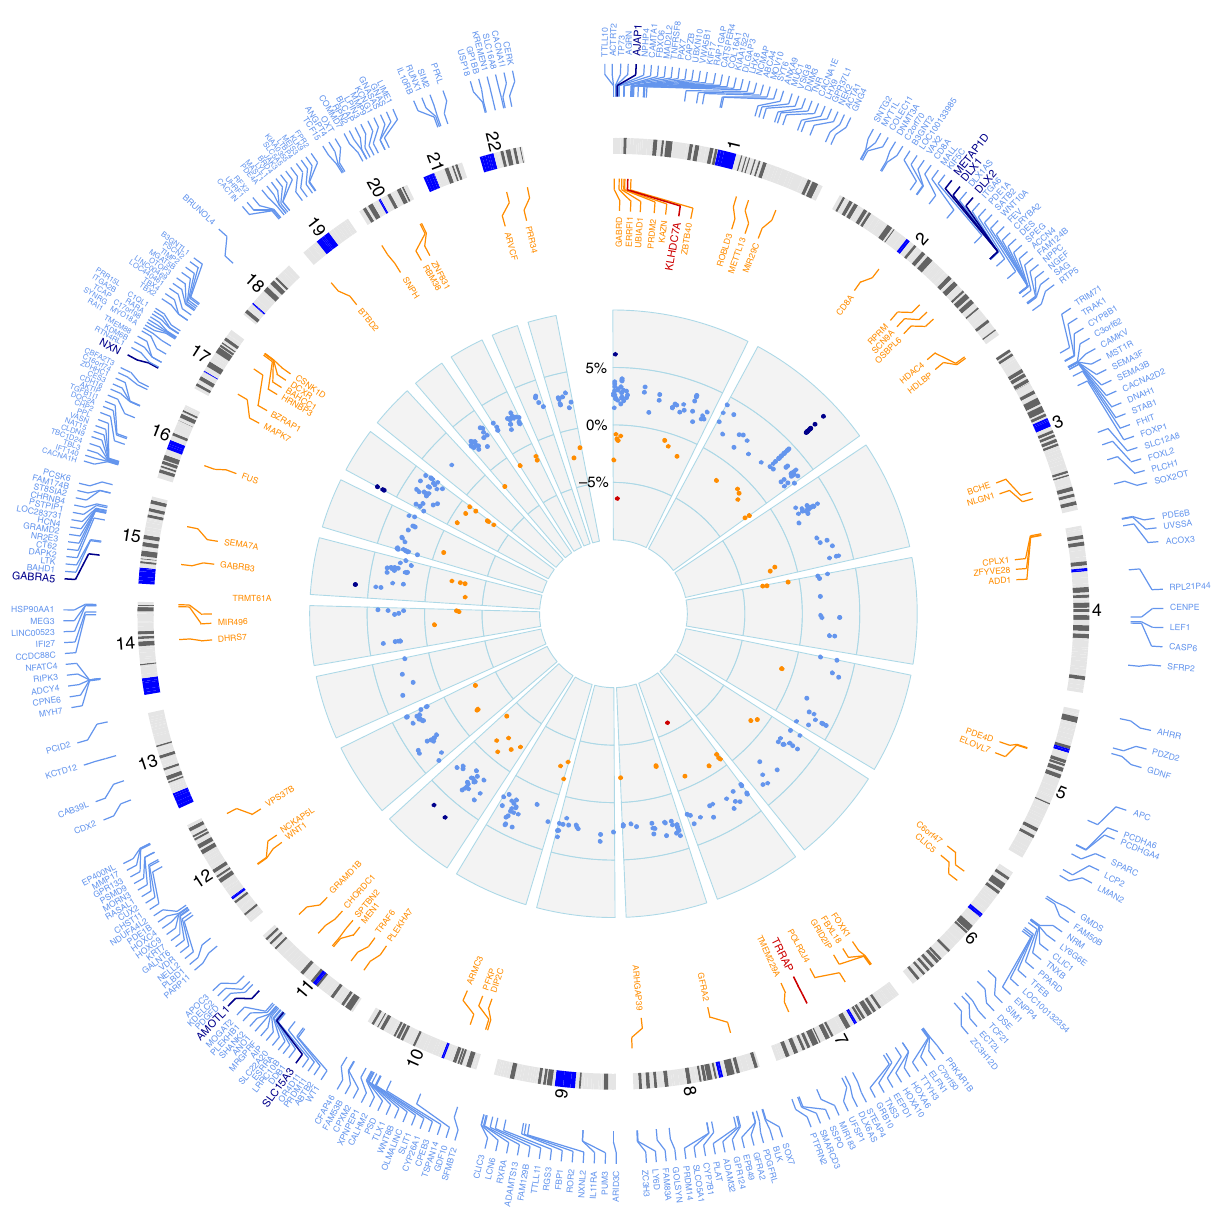
Fig. 2 Circle plot of aberrantly methylated genes. n = 451 CpGs in protein-coding genes and n = 26 CpGs in non-coding RNA genes were found differentially methylated. After removal of duplicates, i.e., genes with more than one differentially methylated CpG, n = 375 genes show differential methylation in PSP patients. The two outer circles list the autosomal positions of n = 375 differentially methylated genes (Benjamini-Hochberg corrected P < 0.05; PSP vs. controls; hypomethylated < 5% (orange), ≥ 5% (red); hypermethylated < 5% (light blue), ≥ 5% (dark blue)). The intermediate circle depicts ideograms of the human autosomes head to tail. The inner circle displays the difference between hyper- (blue dots) and hypomethylation (orange/ red dots) in percent at CpG sites in patients vs. controls. The highest degree of hypermethylation was detected at DLX1/DLX1AS (chromosome 2). This plot was generated according to Hu et al. 63